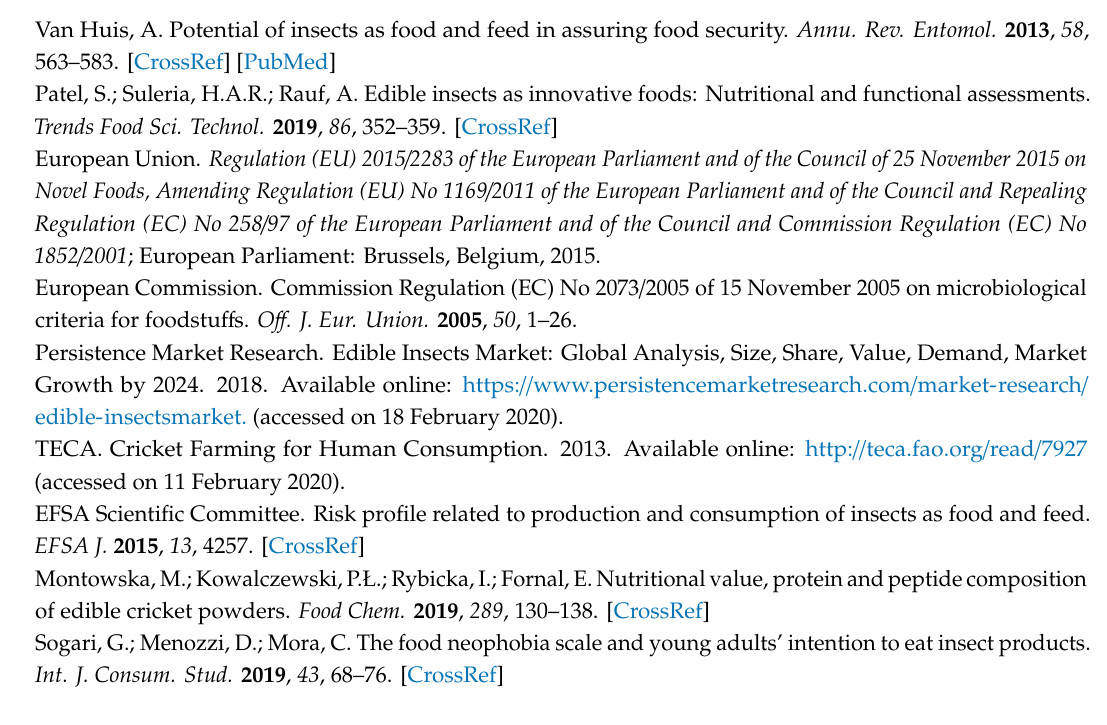
Figure S1: Randomly amplified polymorphic DNA-polymerase chain reaction (RAPD-PCR) patterns; Figure S2: LAB peptidase activities; Figure S3: Growth and pH kinetics of lactic acid bacteria in the MRS broth; and Table S1: Acidification parameters, volume increase, and microorganism concentrations of the doughs at the end of